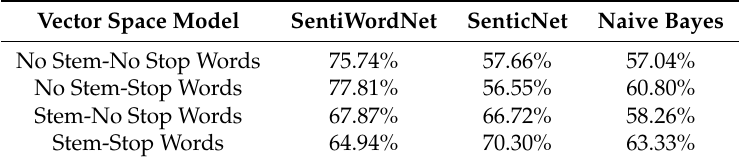
Table 5. Classification rate representing the precision from the SentiWordNet, SenticNet and naive Bayes techniques for opinion mining: vector space models from the movies test